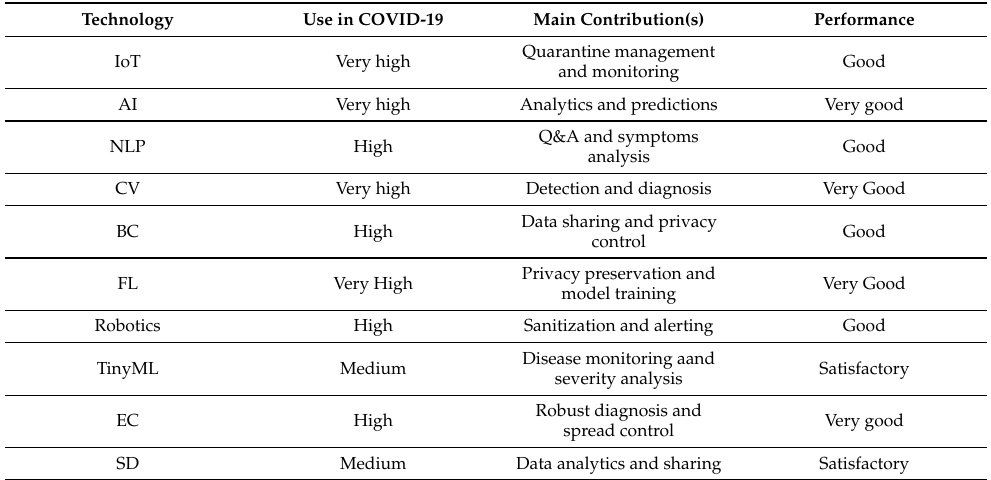
Data analytics and